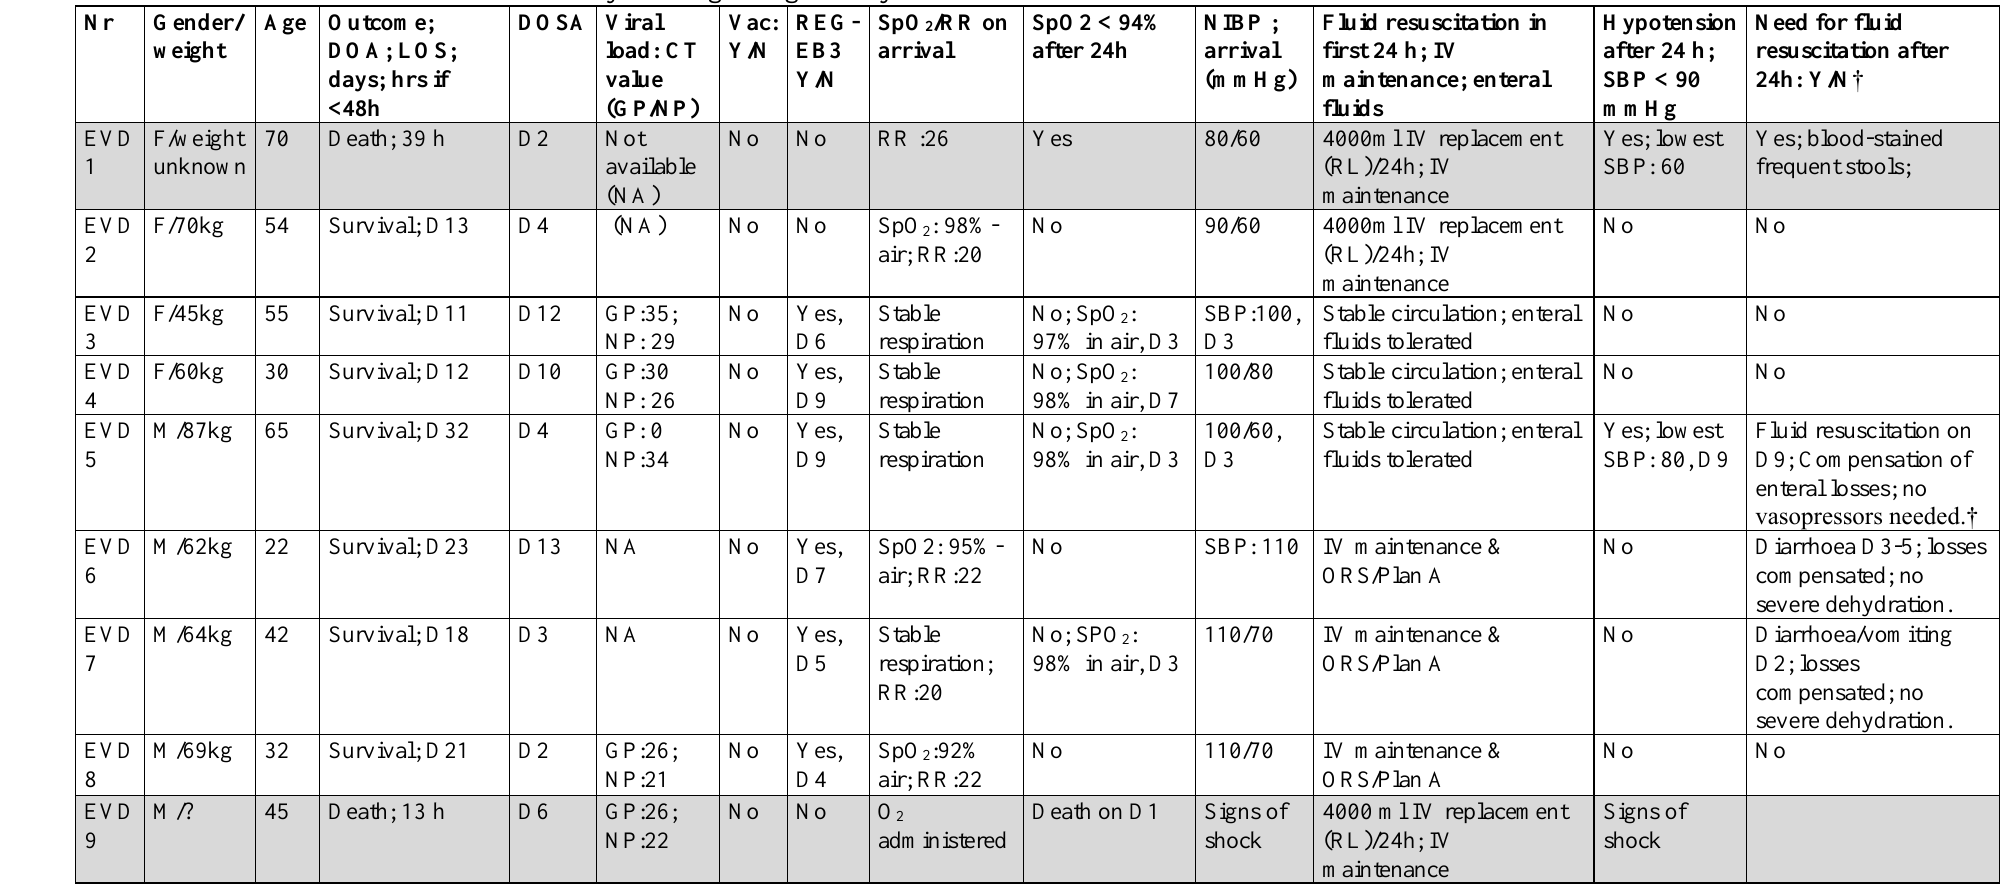
Table 1 A: Information on the 13 EVD-patients and one patient with Lassa virus disease (LVD). 43 Clinical presentation, organ function, treatment and clinical outcomes are documented. Rows of non-survivors are shaded grey. Patients were admitted between the onset of the Ebola outbreak mid-February and beginning of May 2021. List of abbreviations: see end of the